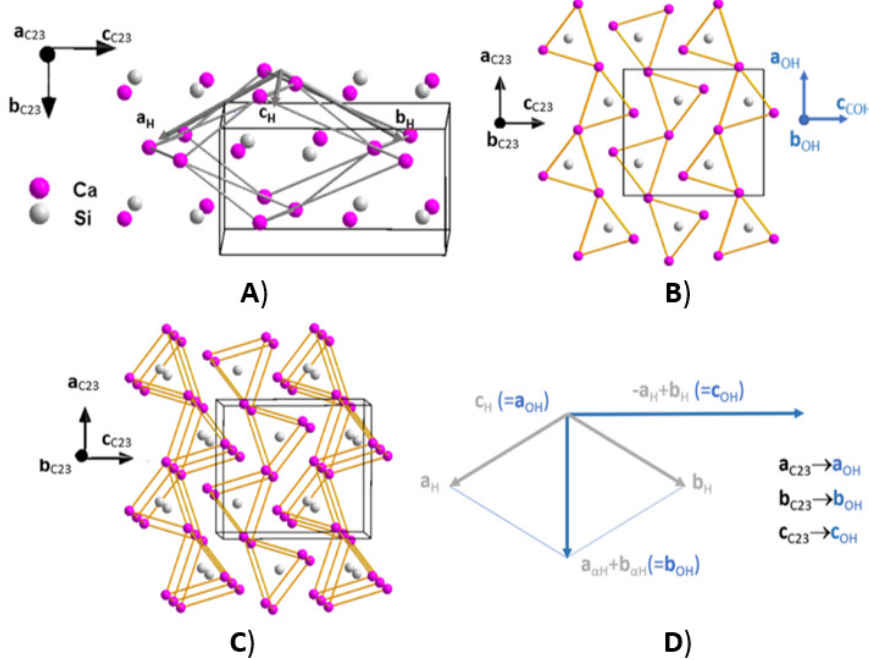
Figure 2. ( A ) Arrangement of atoms in the cell of the Ca 2 Si structure cell. Light grey lines joining Ca cations indicate the orientation of the hexagonal part of the structure within the prototype structure C23. With dark grey vectors the orientation of the reference hexagonal cell is also shown. ( B ) “Walls” of trigonal prisms parallel to the planes (001) projected on the (010) planes. The former planes are normal, and the latter ones are parallel to the plane of the figure. The relative orientation of the ortho-hexagonal reference system is also indicated. ( C ) Presents a tilted view of ( B ). ( D ) Schematic presentation of the unit cell axes relations for the hexagonal and ortho-hexagonal cells. The corre- spondences of the cell axes of the orthorhombic C23 type structure with those of ortho-hexagonal cell are also indicated.